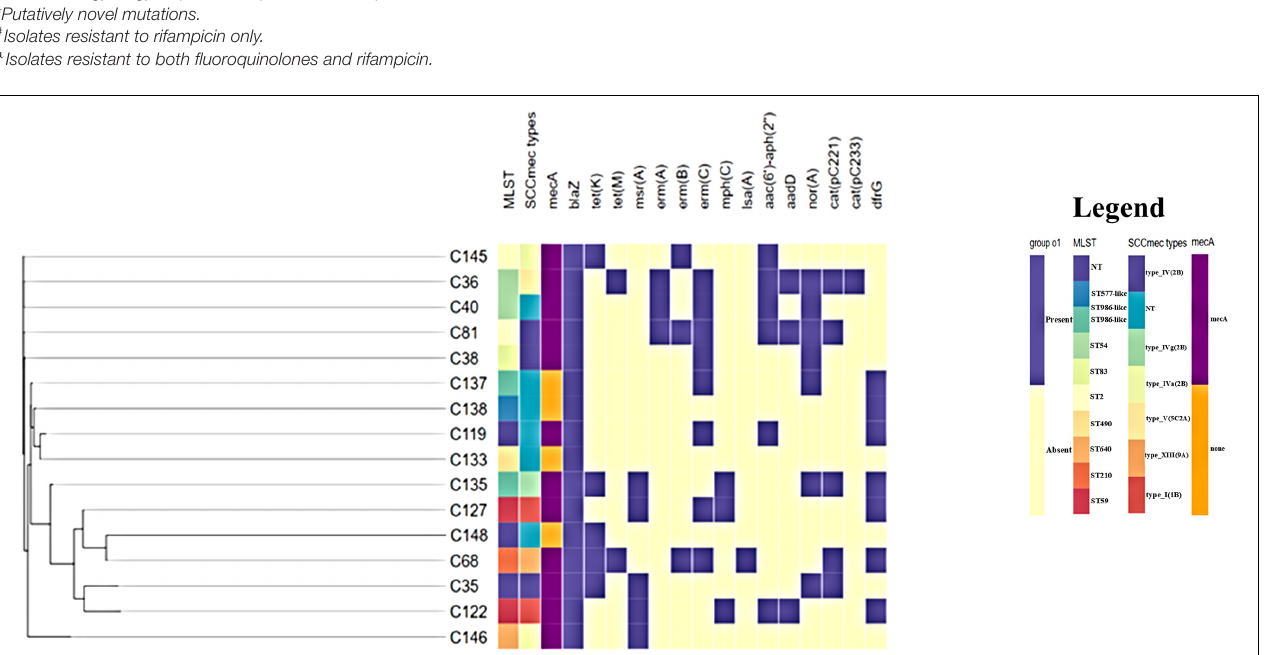
FIGURE 1 | Whole-genome phylogenetic tree annotated with sequence type (ST) assignment, SCC mec types, and antibiotic resistance carriage. Gene names above the annotation according to antibiotic class, as follows: β -lactams: mecA and blaZ ; tetracyclines: tet(K) and tet(M) ; macrolide, lincosamide streptogramin B: msr(A) , erm(A) , erm(B) , erm(C) , lsa(A) , and mph(C) ; aminoglycosides: aac(6 (cid:48) )-aph(2 (cid:48)(cid:48) ) and aadD ; efflux pump: norA ; trimethoprim: dfrG ; chloramphenicol: cat(pC221) and cat(pC233) . The profile was generated using Phandango (https://jameshadfield.github.io/phandango/#/). Heat map at the middle indicates antibiotic resistance gene presence (purple) and absence (yellow). NT,